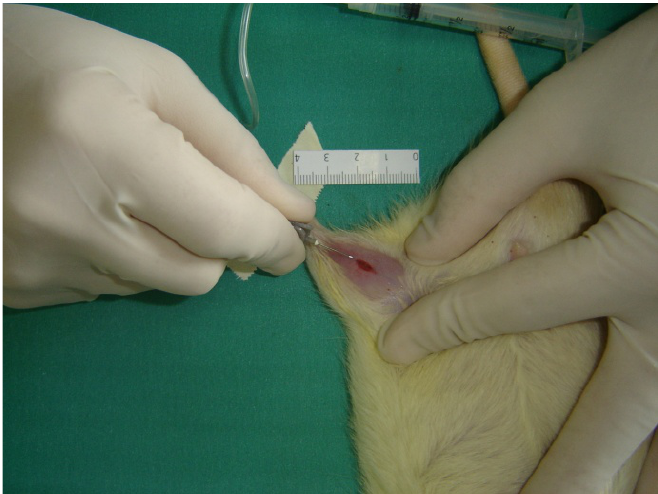
FIGURE 1 - Insertion of intravenous plastic catheter for nutraceuticals infusion